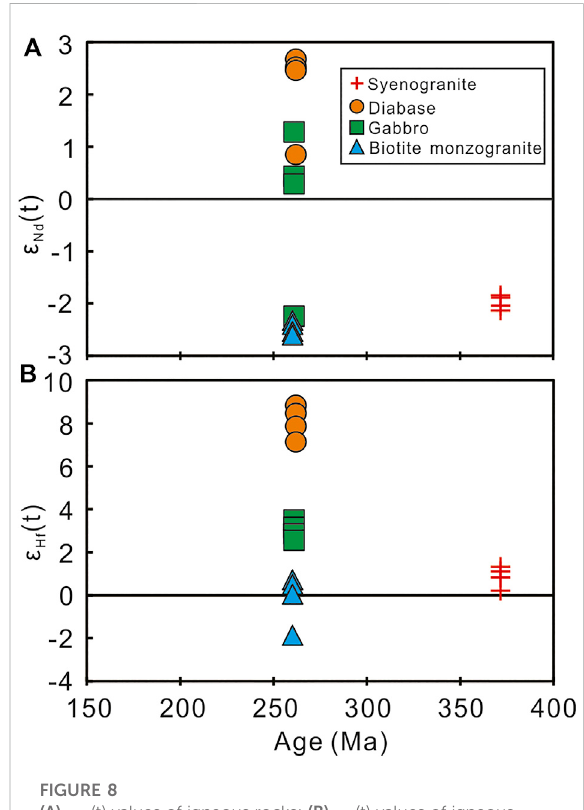
FIGURE 8 (A) ε Nd (t) values of igneous rocks; (B) ε Hf (t) values of igneous